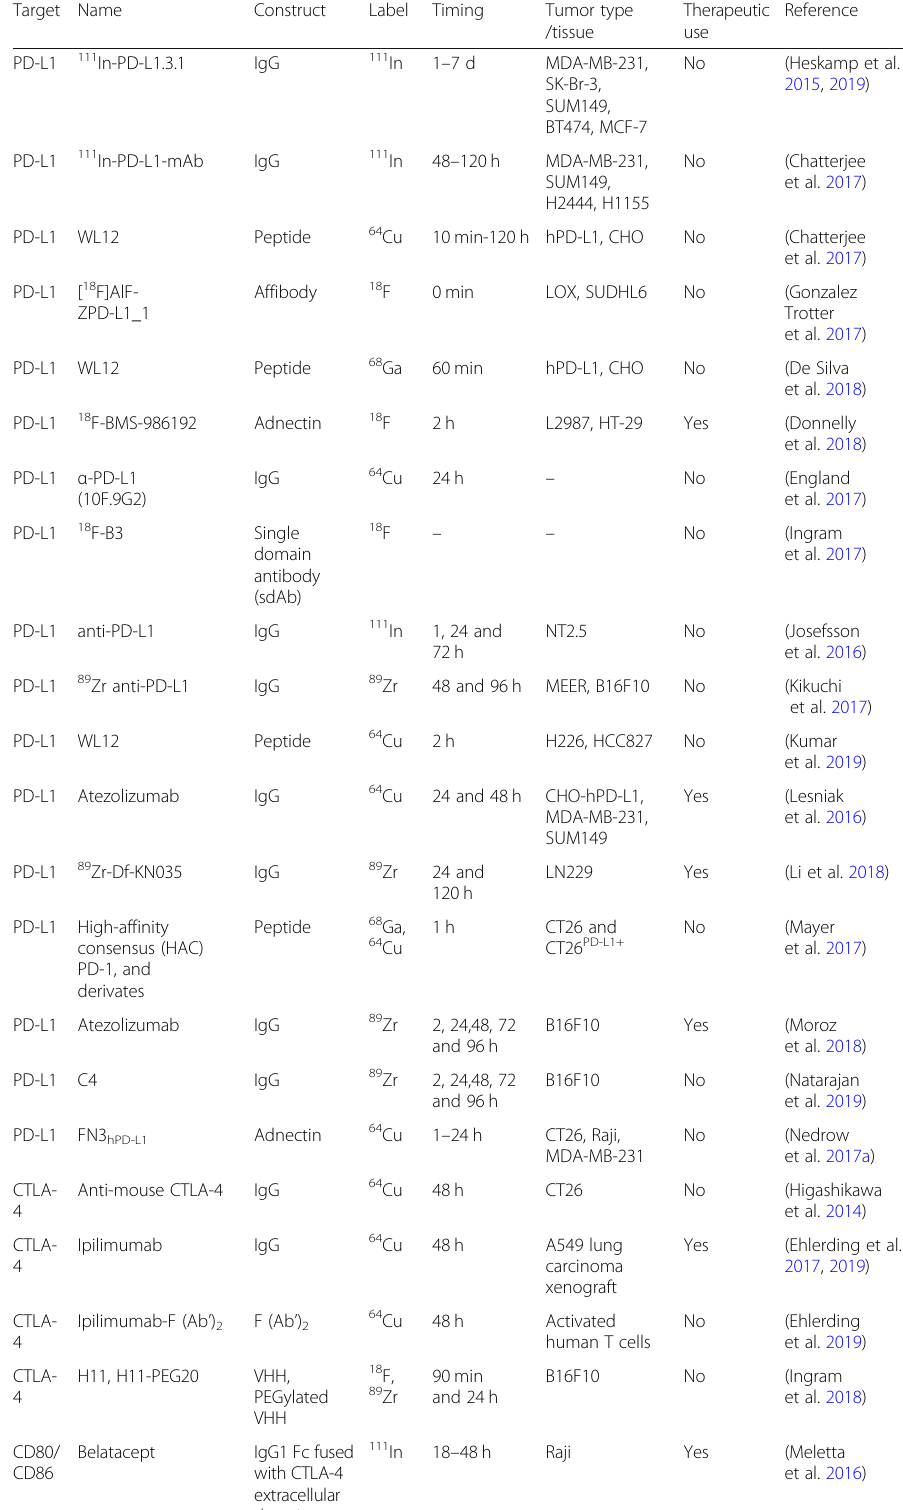
Table 1 Overview of nuclear imaging tracers for immune checkpoints. Only tracers that have been published and used in at least preclinical in vivo studies are described in the tables below